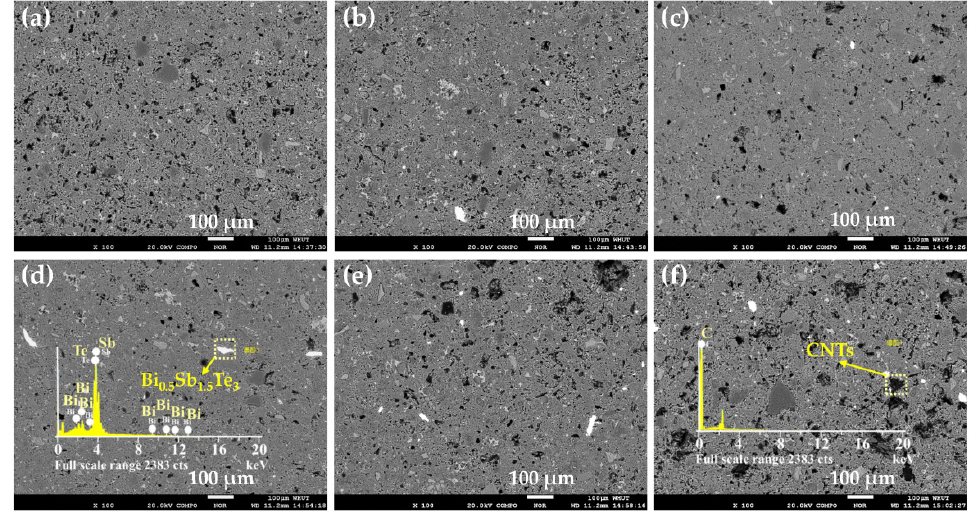
Figure 4. BEI photographs of Bi 0.5 Sb 1.5 Te 3 /CNTs cement composites at different Bi 0.5 Sb 1.5 Te 3 con- tents: ( a ) x = 0.0 vol.%; ( b ) x = 0.2 vol.%; ( c ) x = 0.4 vol.%; ( d ) x = 0.6 vol.%; ( e ) x = 0.8 vol.%; and ( f ) x = 1.0 vol.%.